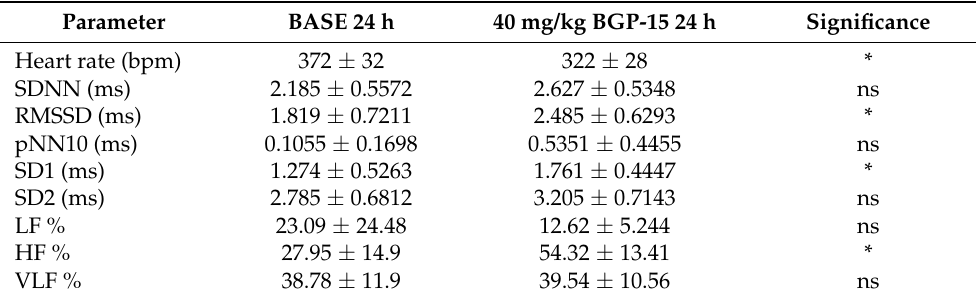
Table 1. Twenty-four hour HRV parameters of telemetry-implanted rats in baseline conditions (BASE) and during 40 mg/kg BGP-15 treatment. Normal distribution was assessed by the Shapiro–Wilk normality test. Asterisks denote significance ( p < 0.05, paired Student’s t -test). Parameter BASE 24 h 40 mg/kg BGP-15 24 h Significance Heart rate (bpm) 372 ± 32 322 ±